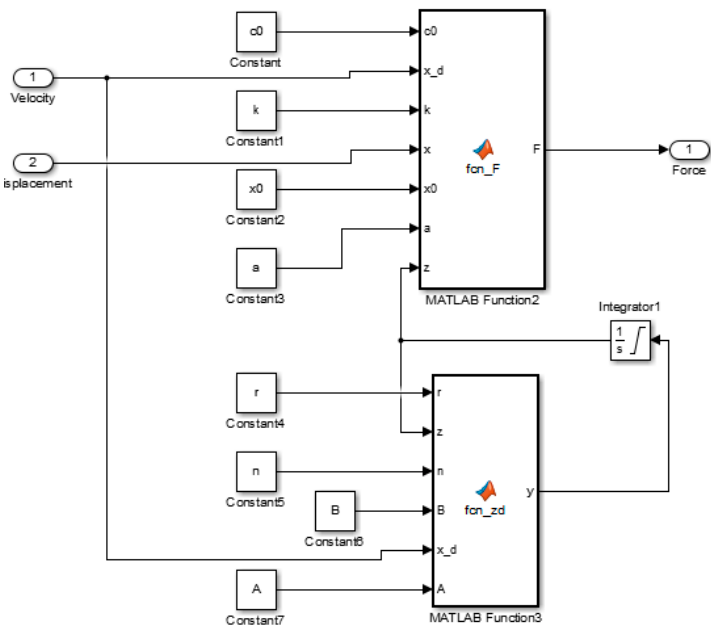
Figure 6. Damping characteristics test of the MRF damper. Table 2. Identification result of Bouc-Wen model parameters.